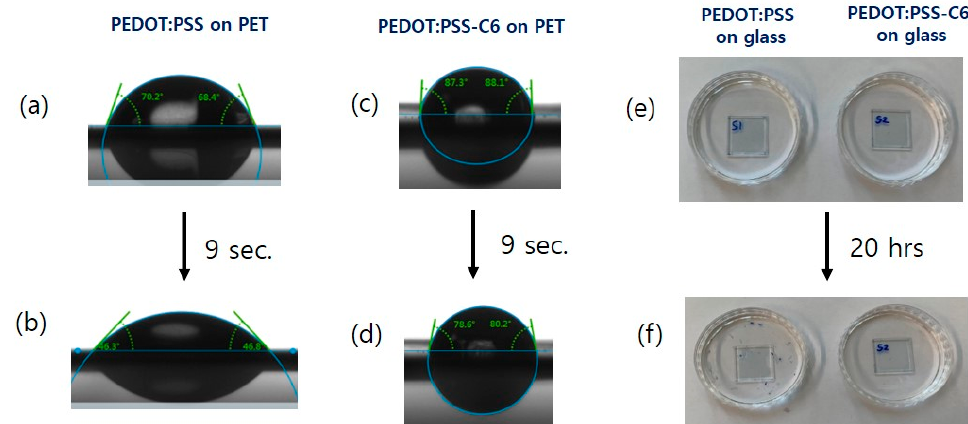
Figure 6. Image of contact angles formed by liquid water drops on the surface of ( a ) PEDOT:PSS film, ( c ) PEDOT:PSS-C6 film, and ( b , d ) after 9 s for each film. Photos of ( e ) PEDOT:PSS and PEDOT:PSS-C6 film immersed in water, and ( f ) after 20 h.